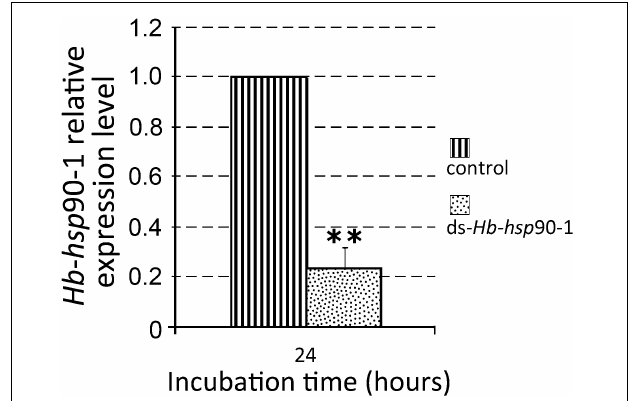
Heterorhabditis bacteriophora treated with dsRNA. Control consisted of